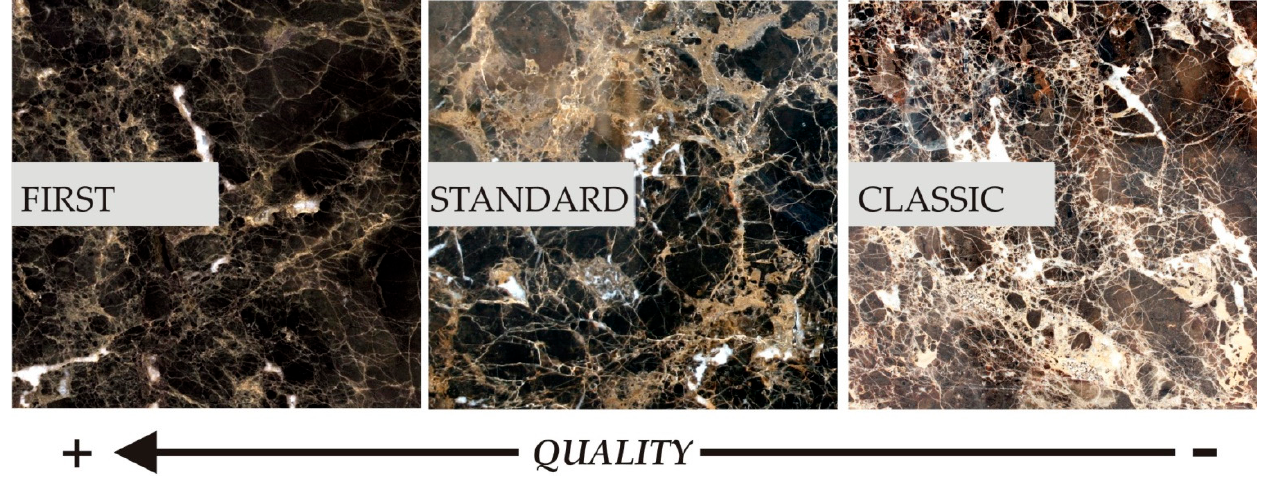
Figure 1. Varieties of Marrón Emperador commercial marbles marketed by Mármoles Hnos. Jiménez (Spain). https://hnosjimenez.com/marmol-marron-emperador/ (Accessed on: 8 February 2022).